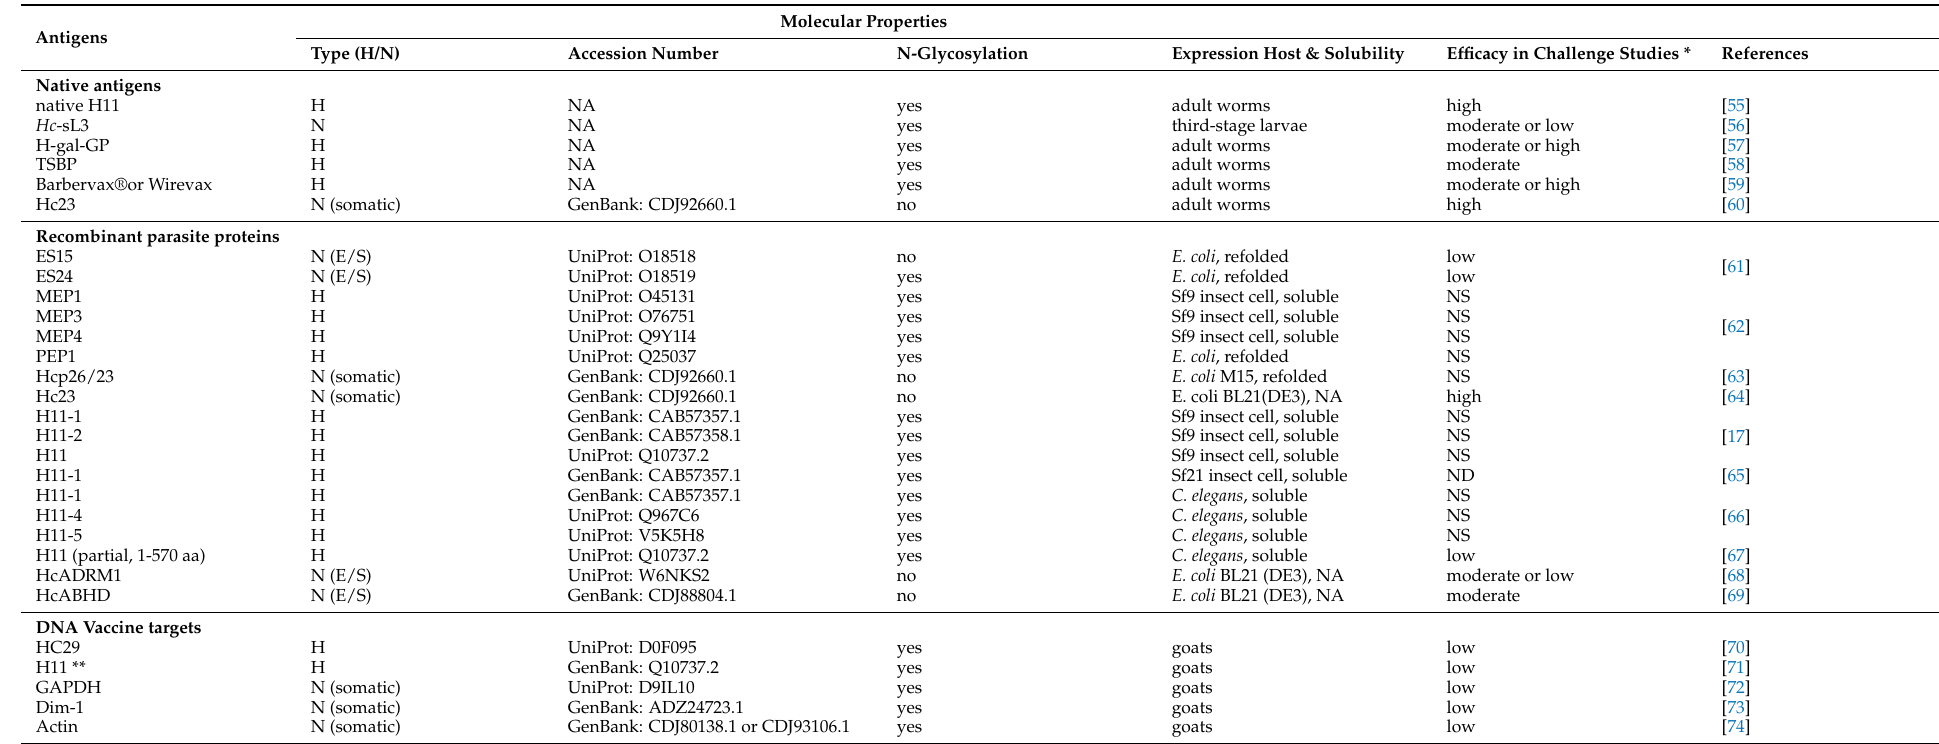
Table 1. Vaccine candidates listed here are from protein-based Haemonchus contortus antigens that have been tested in host animals and indicated degrees of protection. Their accession numbers, if not mentioned in literature, were determined by performing Nucleotide BLAST search (BLASTn) using reported primer sequences for molecular cloning. N-glycosylation sites were predicted using NetNGlyc—1.0 server [54]. * Defined by the reduction of faecal egg counts compared with adjuvant control group; >80% as high, between 50% and 80% as moderate and <50% as low. ** Described as H11-1 in the publication by mistake. BLASTn search with primers, which were used for amplifying the three gene fragments, indicated that the authors actually cloned the H11 encoding gene (GenBank: X94187.1). Abbreviations: NS, no significant differences; NA, not applicable, ND, no